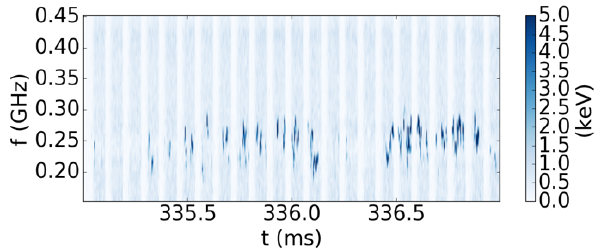
Fig. 4. Fast time-behavior of Type 2 emissions (shot #40772). Emissions seem linked with the presence of a m:n=2:1 MHD island and their characteristic frequency shift may vary during the plasma evolution (from 0.25 GHz to 0.3 GHz and back to 0.2 GHz, as in the case of shot #40772 , correlated to the probe in the poloidal direction by a 3 degrees angle in 30